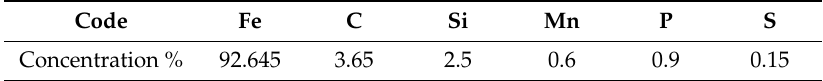
Table 1. Chemical composition determined by an arc/spark